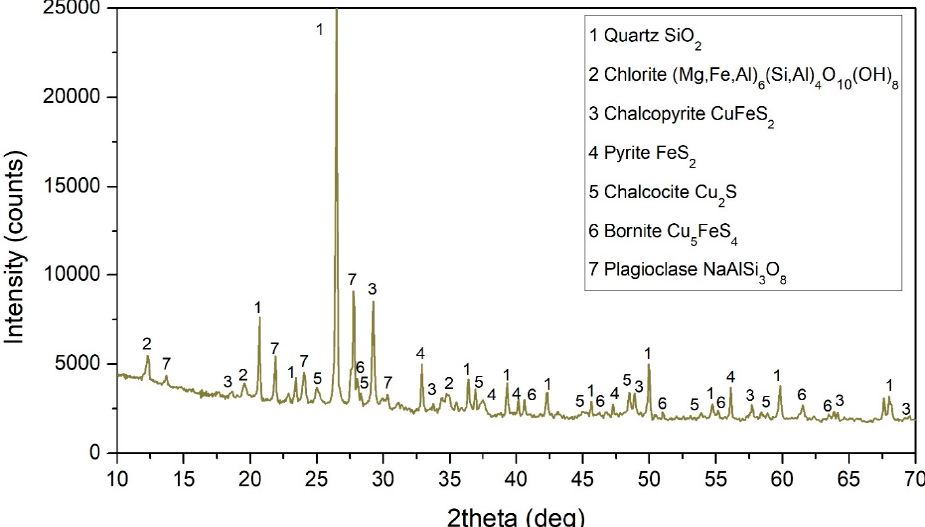
Figure 1. XRD pattern of initial low-grade copper–silver concentrate.